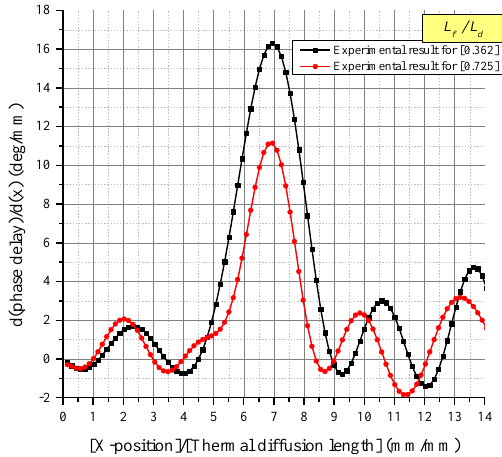
Figure 17. LSF of the experimental results.